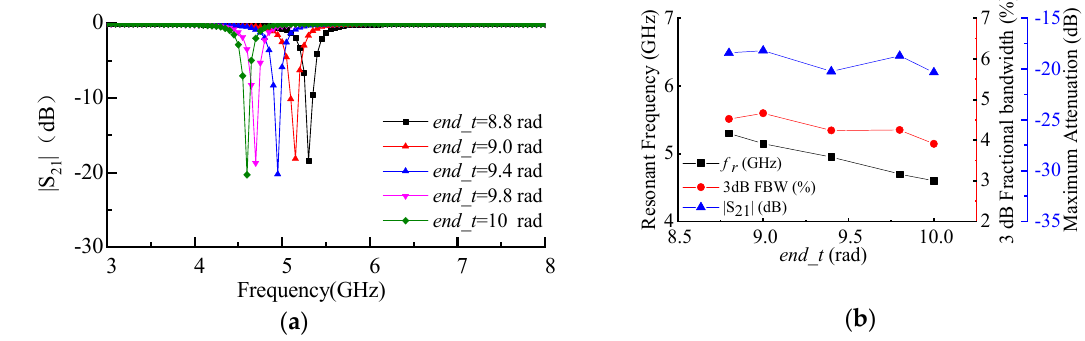
Figure 8. ( a ) Simulation results with different end_t by using HFSS. ( b ) Resonant frequency, maximum attenuation, and 3 dB Fractional Bandwidth with different end_t.